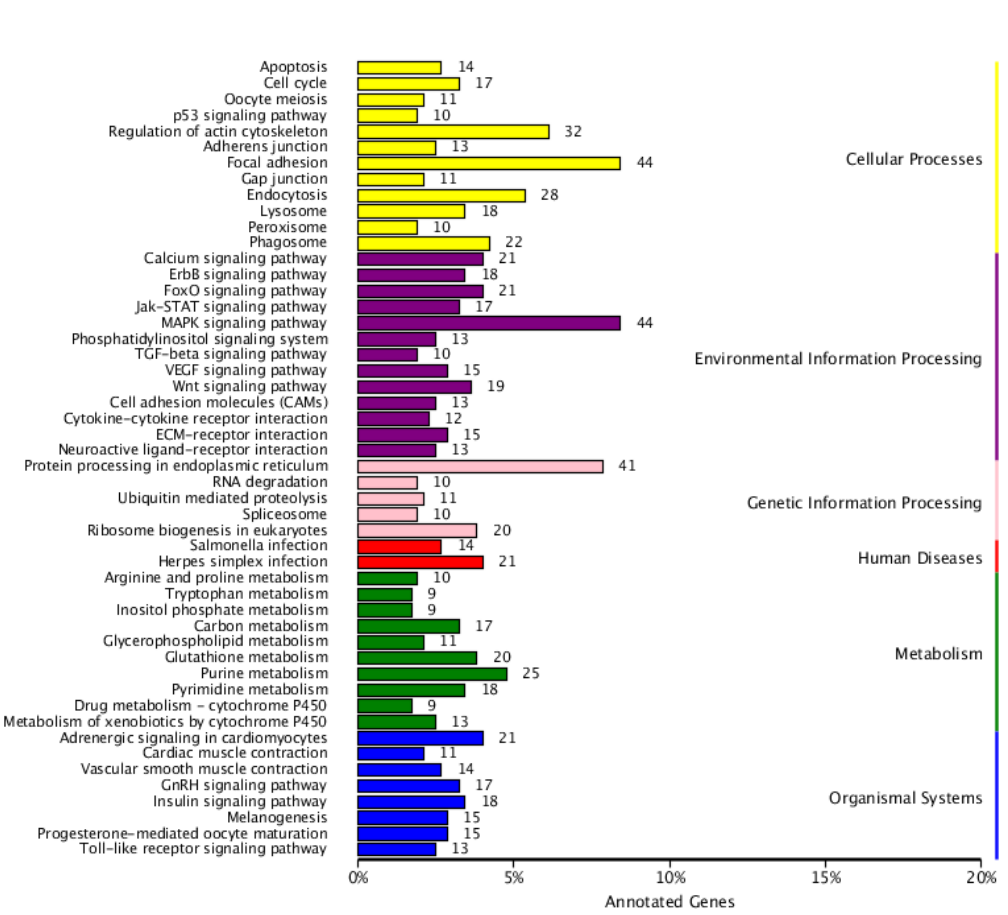
Figure 7. KEGG classification of differentially expressed genes. The ordinate is the name of the KEGG metabolic pathway, and the abscissa is the ratio of the number of genes annotated to the pathway and the number of genes in the annotated genes.